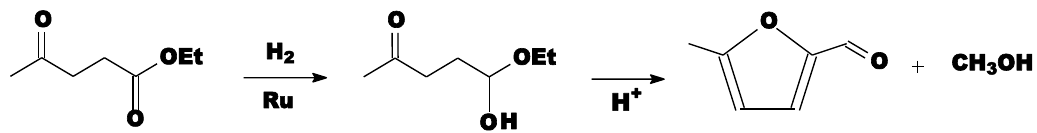
Figure 12. Cascade conversion of ML to GVL via hydrogenation followed by intramolecular dealcoholization. Modified with permission from reference [33]. Copyright 2016 Royal Society of Chemistry.